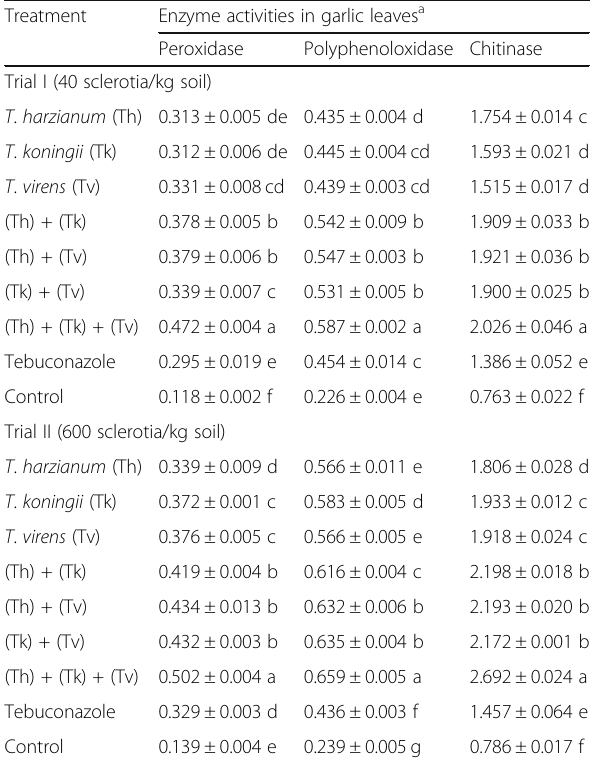
Table 5 Effects on peroxidase, polyphenoloxidase, and chitinase enzymes activities of garlic plants under field conditions at 100 days after planting